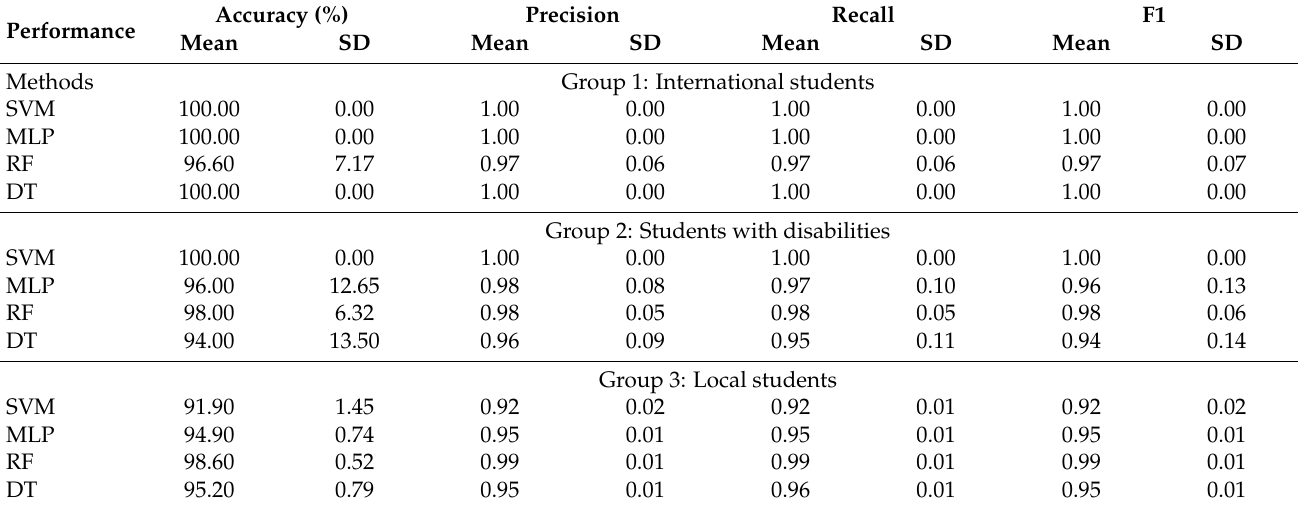
Table 5. Classification results of Case 3 (Random oversampling the minority (ROM)).